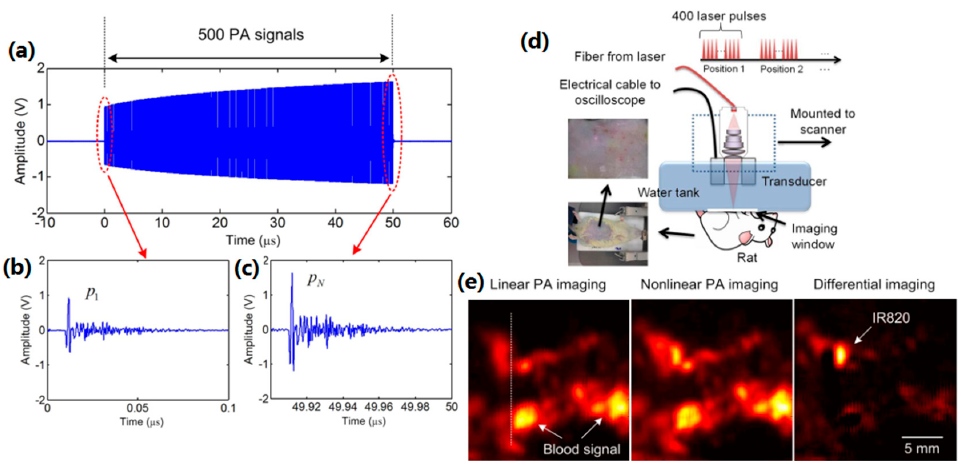
Figure 12. ( a ) A typical 500 PA signal, ( b ) the first linear PA signal, and ( c ) the last nonlinear PA signal. ( d ) In vivo experimental setup based on the LDPA technique by quasi-CW laser excitation. ( e ) The reconstructed linear PA, nonlinear PA and differential imaging results of a rat with subcutaneous injection of IR820 in the abdomen. Strong PA signals from high-absorptive blood background are shown in the linear and nonlinear PA images. By subtracting, the signal from the IR820 pops up with linear background suppression. Reproduced with permission from Ref. [71].